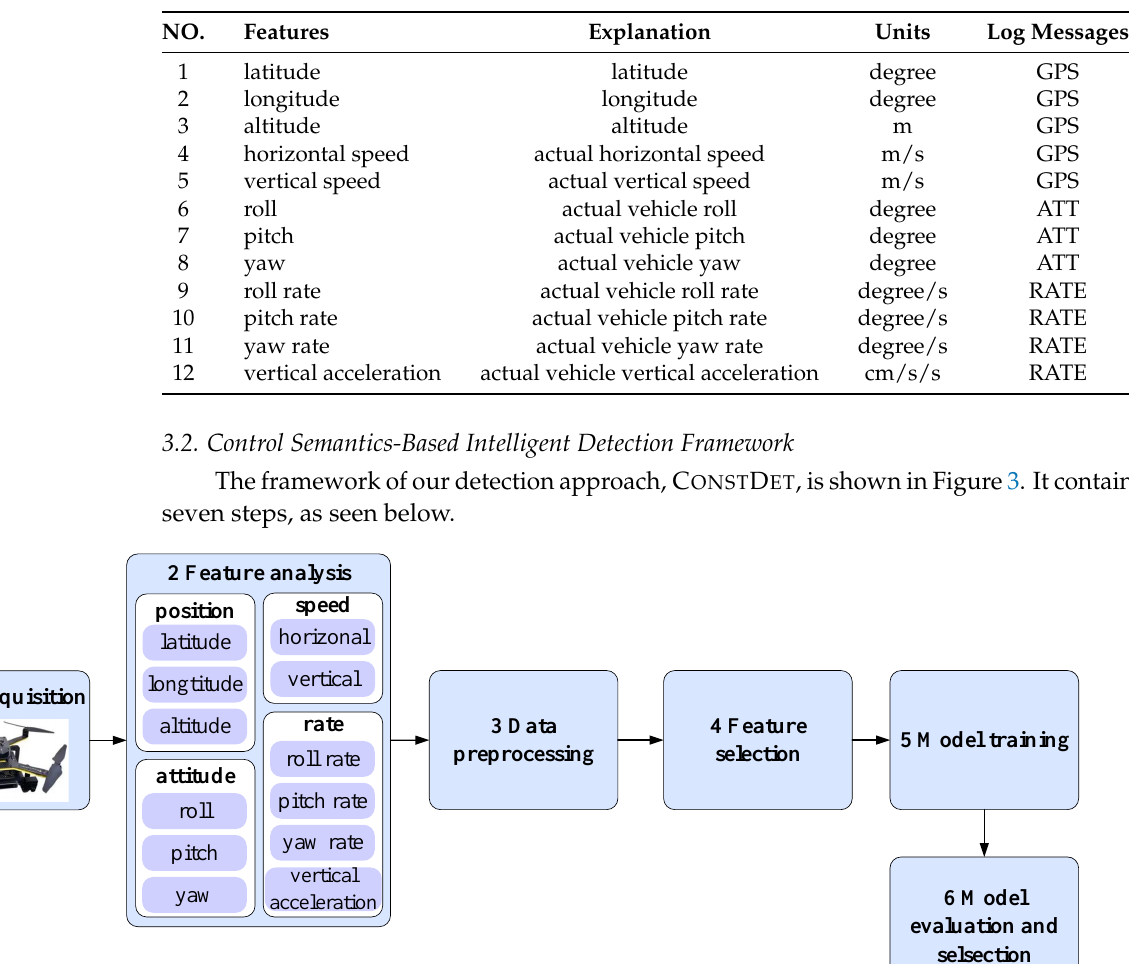
Table 1. Summary of flight data features for model training.